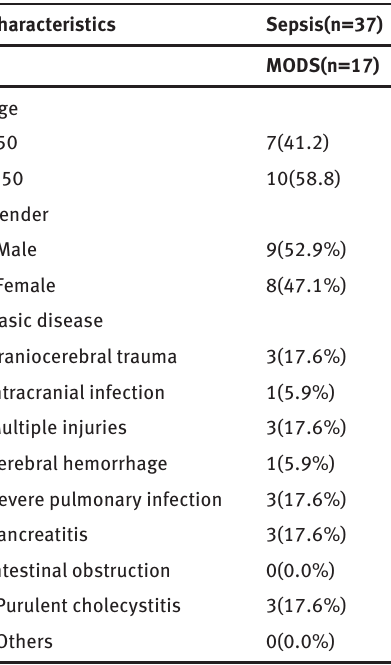
Table 1: General characteristics of the 3